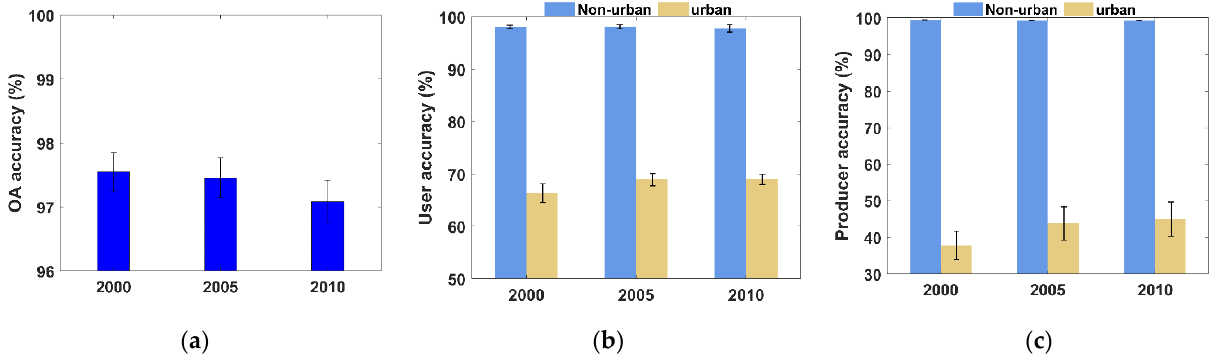
Figure 14. Accuracy estimation of urban expansion and no change in the three periods. ( a ) OA, ( b ) UA, ( c ) PA.